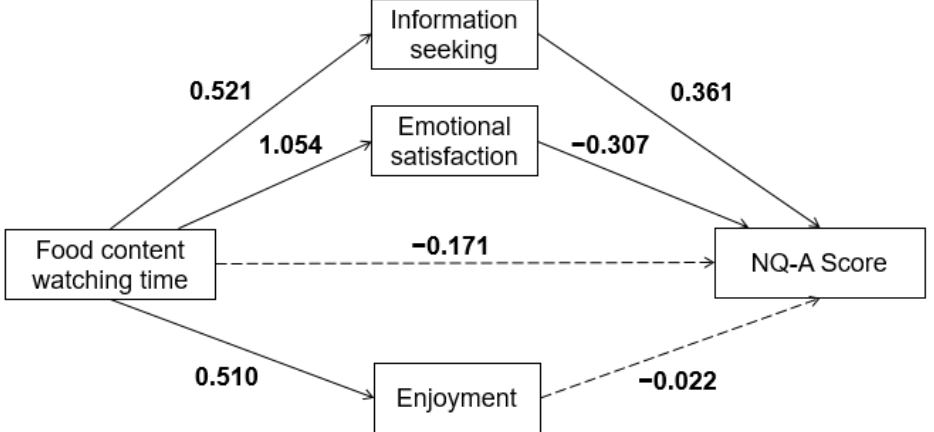
Figure 1. Mediation analysis with the hypothesized mediators of food content watching motives.